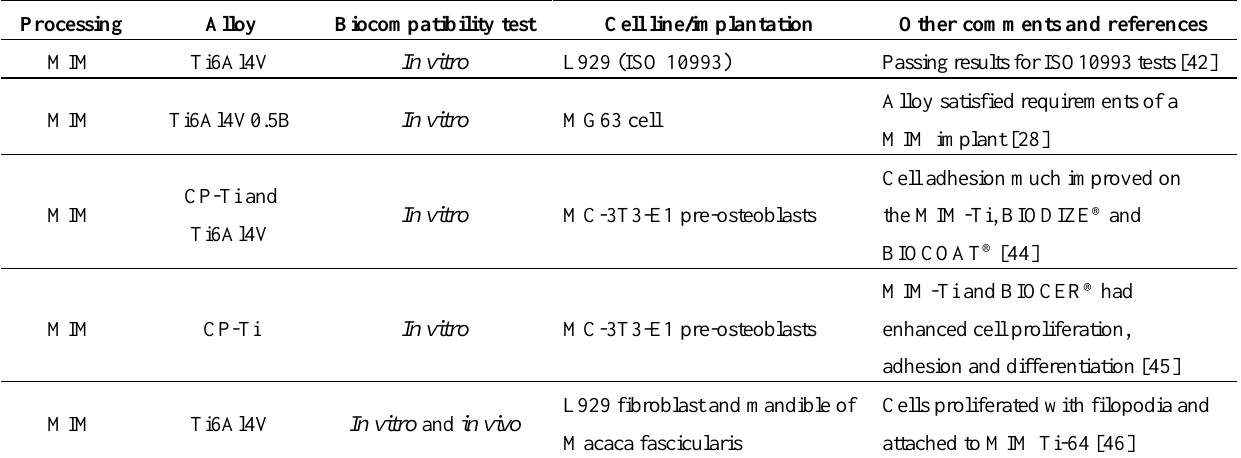
Table 5. Summary of MIM processing and